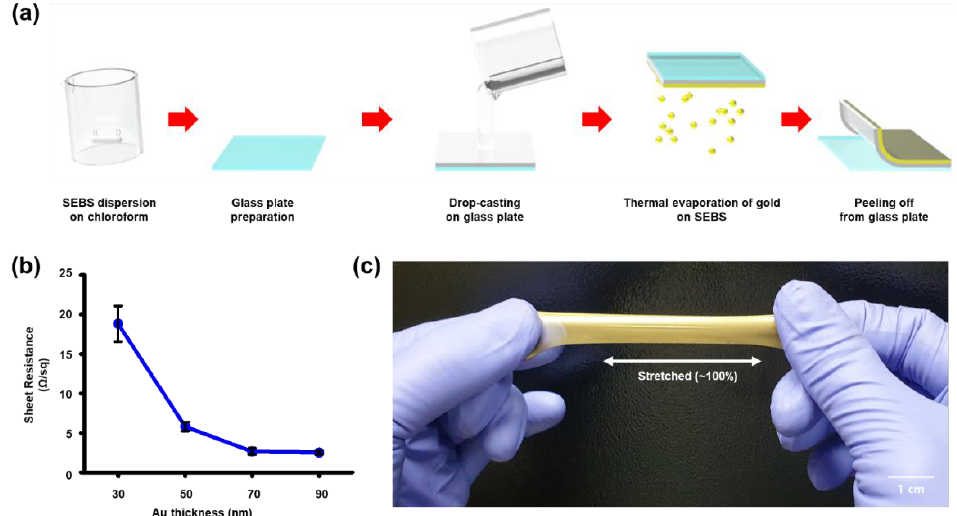
Figure 2. ( a ) Fabrication process of the Au – SEBS electrode. ( b ) Sheet resistance of the Au – SEBS electrodes varied by different Au thicknesses. ( c ) Photograph of the stretchable Au – SEBS electrode.